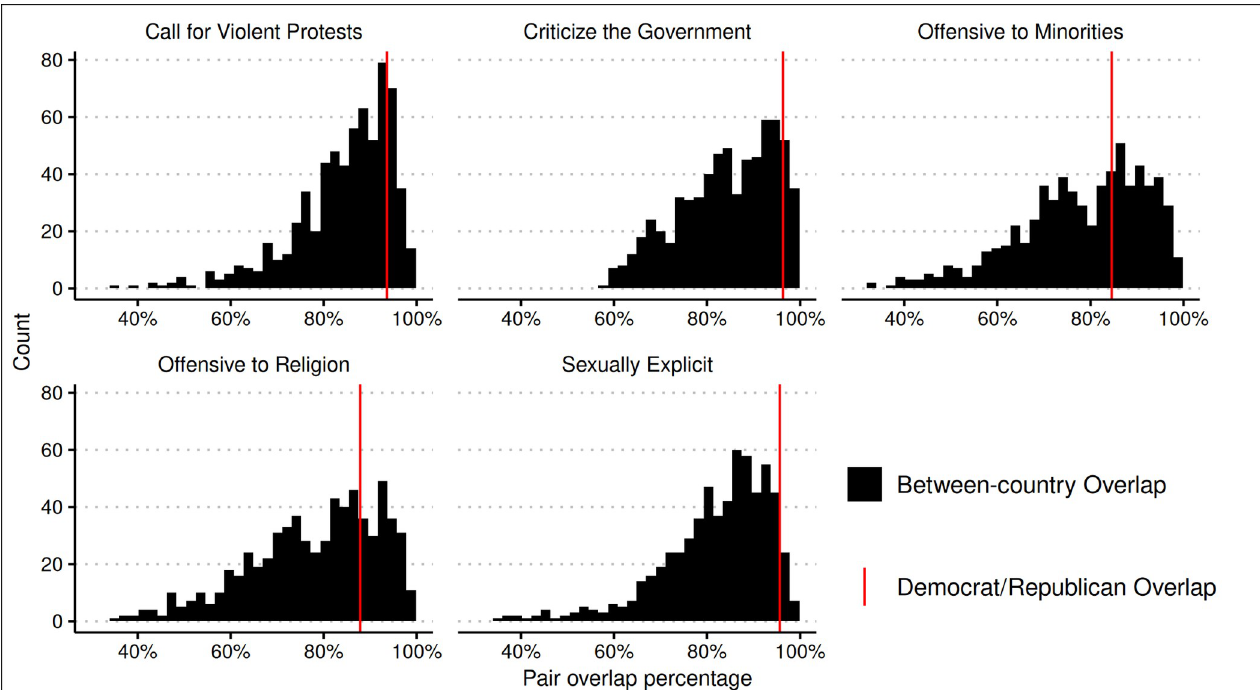
Fig 6. Distribution of all country pair overlap for freedom of speech issues.